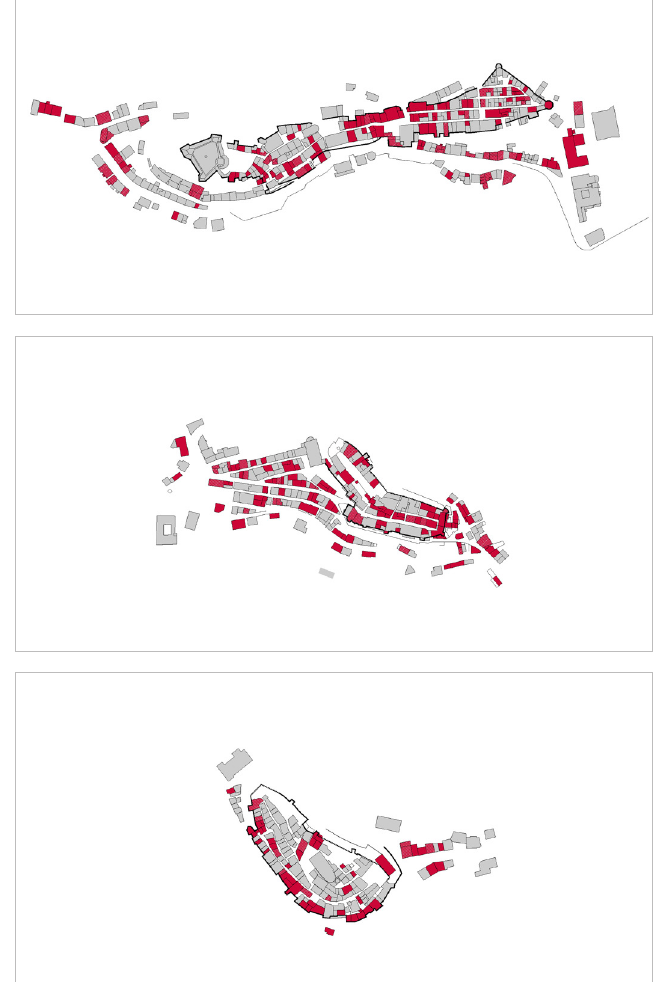
Fig. 19 Caterina Cameli and Iacopo